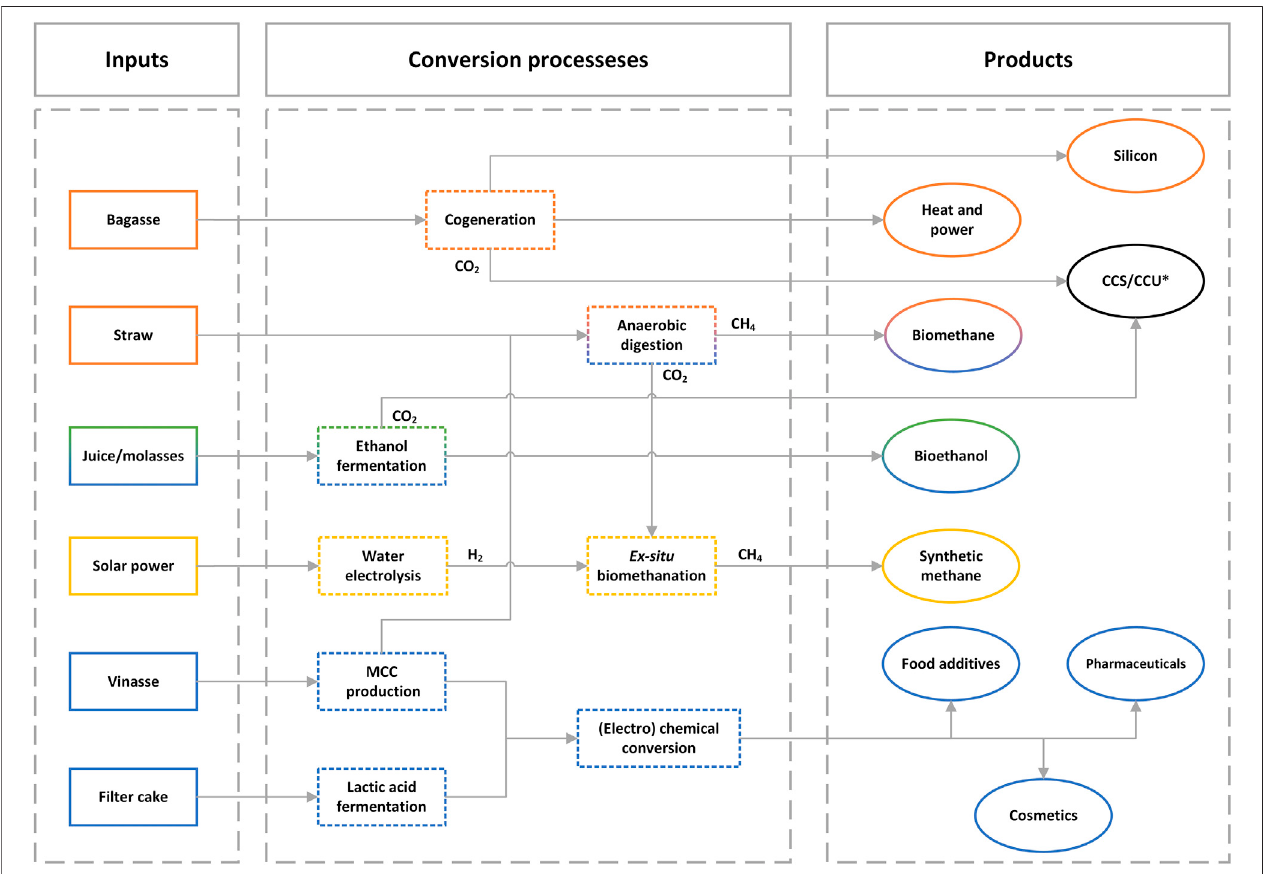
FIGURE 3 | Simpli fi ed scheme of future sugarcane biore fi nery fully implementing the circular economy concept * other CCU than synthetic methane.